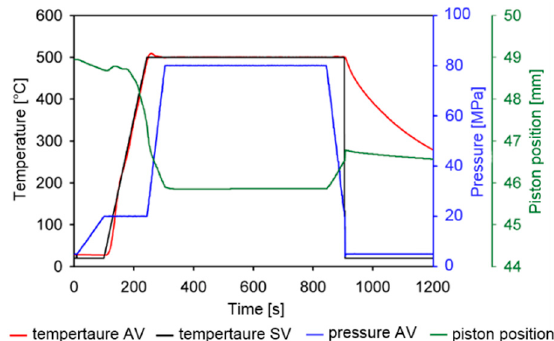
Figure 10. Scheme of the compaction process via SPS for the Al-20Si-10Fe-6Cr alloy (AV, actual value; SV, set point value).